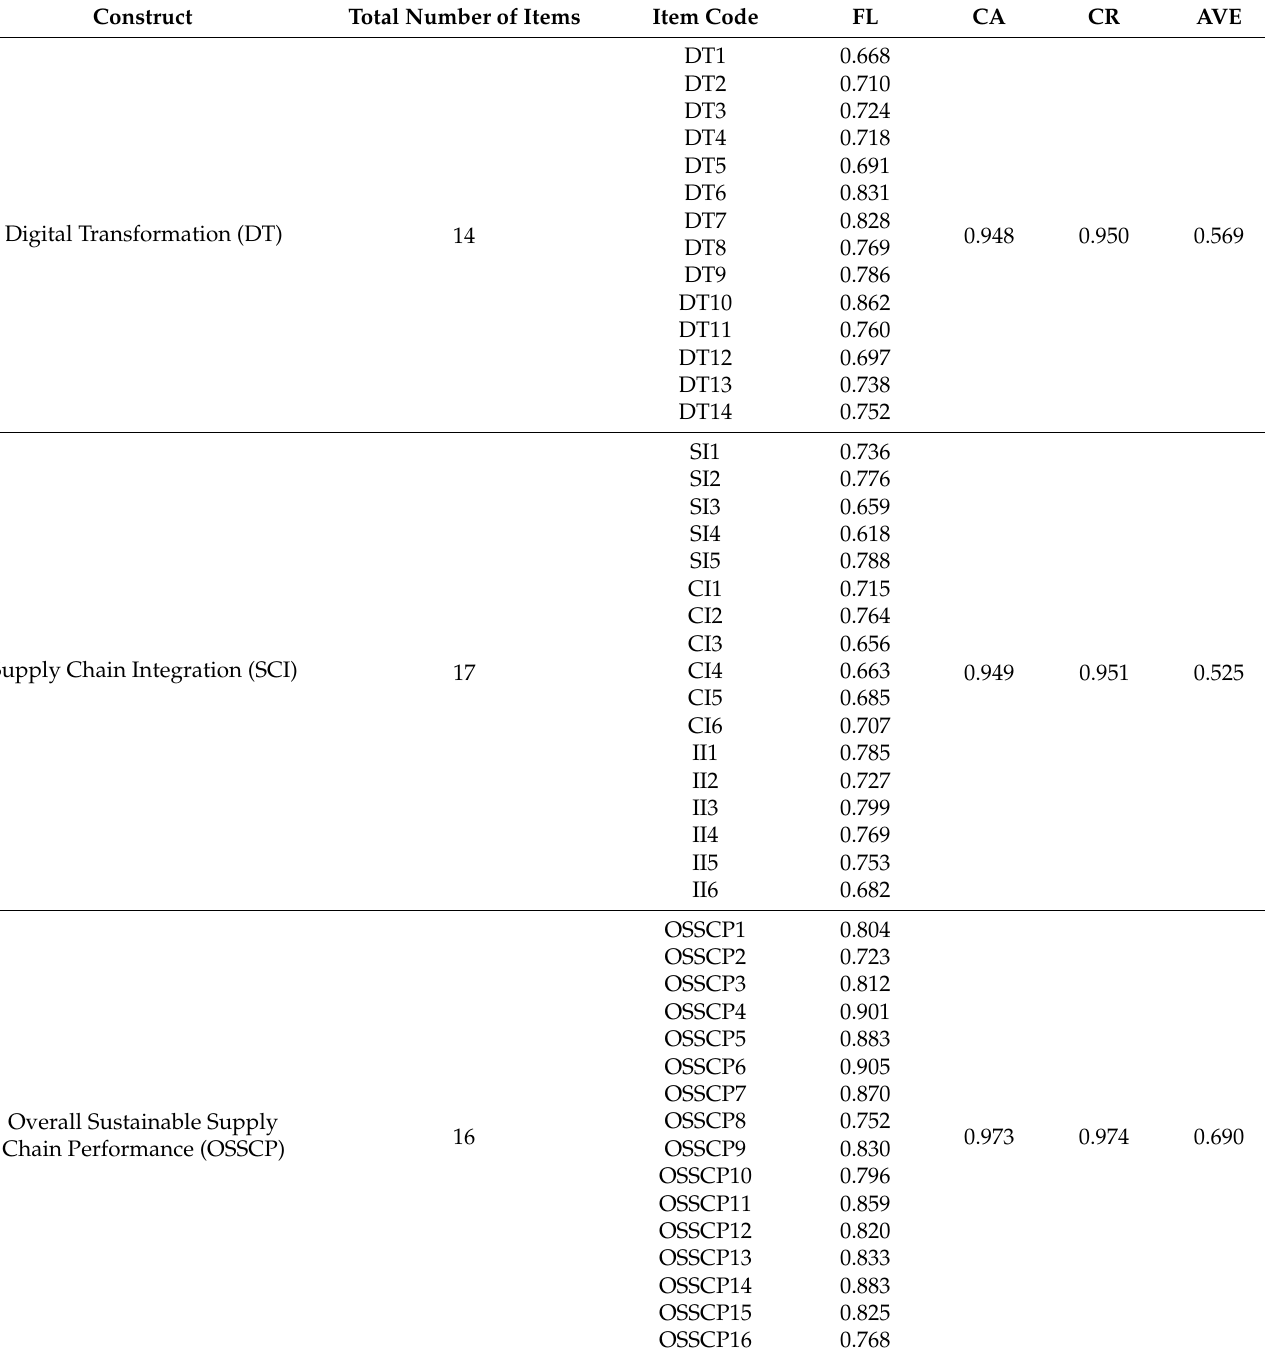
Table 2. Construct reliability and